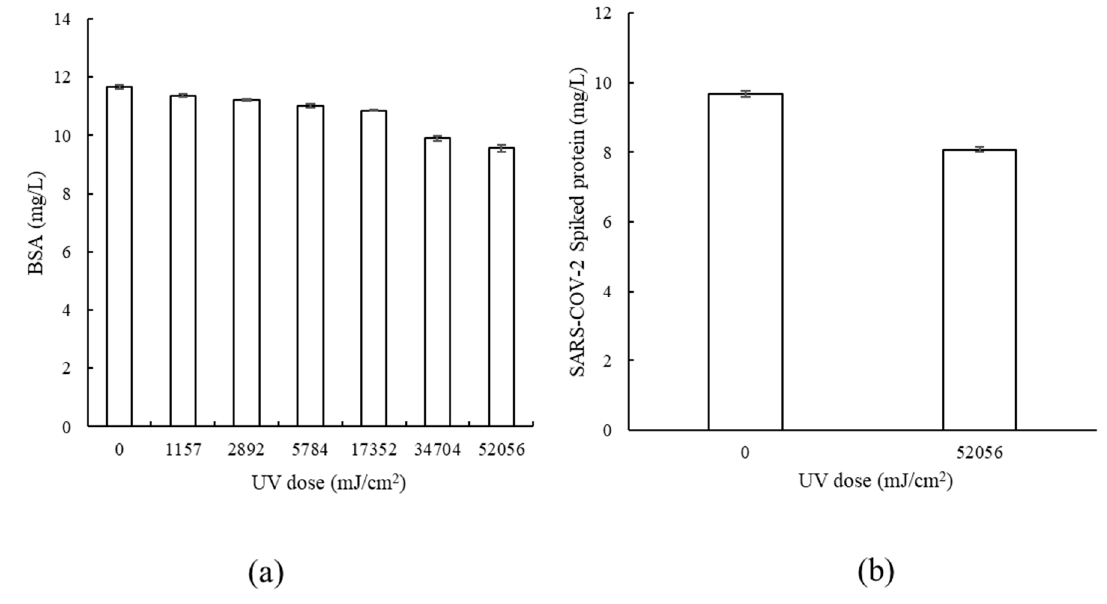
Figure 8. The impact of 280 nm LED irradiation (9640 µ W/cm 2 ) on protein concentrations in wastewater: ( a ) BSA, ( b ) SARS-CoV-2 spike protein.